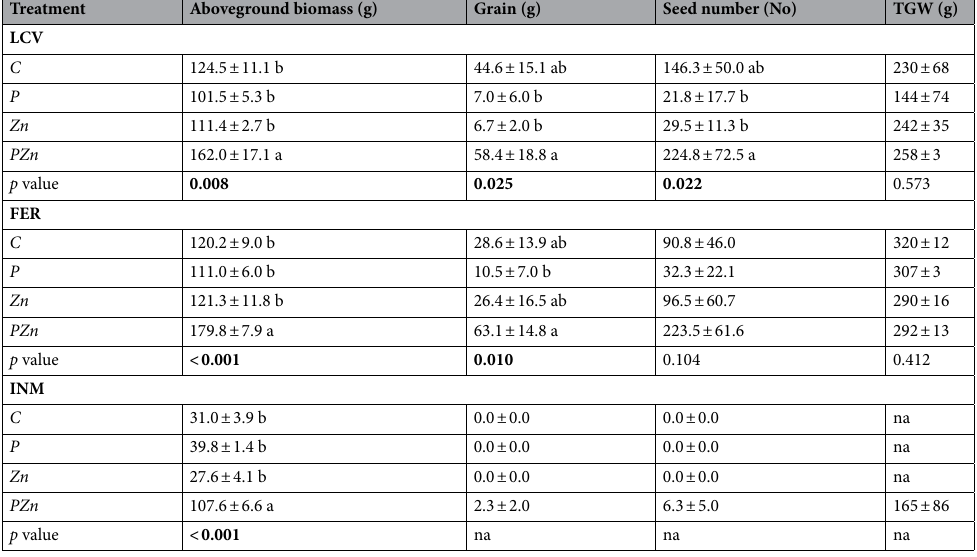
Table 1. Aboveground dry matter (straw and grain), yield (grain), number of seeds per plant and thousand grain weight (TGW) at harvest of maize plants (mean ± standard error, n = 4 except for grain, yield gain, number of seeds and TGW in soil INM, where it was n = 2 in treatment PZn ) as a function of treatment for each soil (LCV, FER and INM). Significant p values are in bold to indicate significant differences. p is the probability level of the one-way ANOVA. Different letters indicate significant differences between treatments according to the posthoc LSD test. C : no P or Zn was added; P : fertilization with 40 mg P kg −1 but no Zn; Zn : fertilization with 3 mg Zn kg −1 but no P; PZn : fertilization with 40 mg P kg −1 and 3 mg Zn kg −1 . na: non-